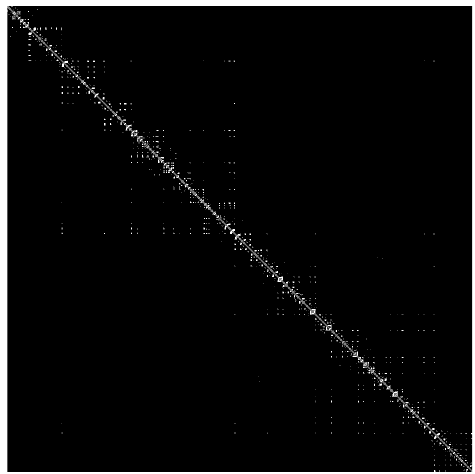
Figure 3. The binary image of the adjacent matrix of the visibility graph